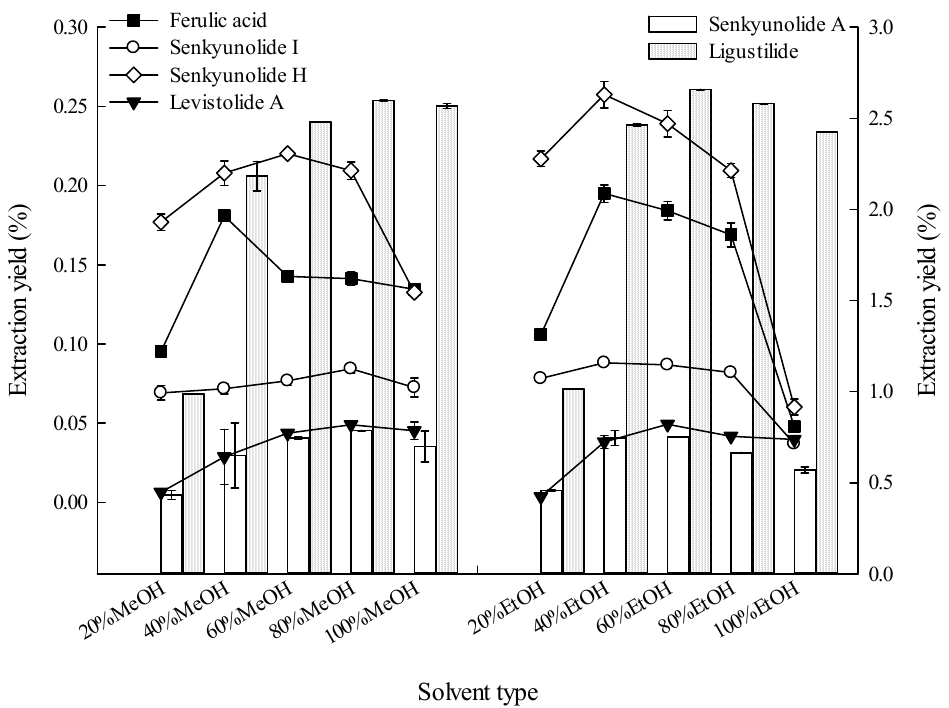
Figure 1. Effects of solvent type on the extraction yields of the six constituents (the lines and bar graphs as referenced to the left and right axes,